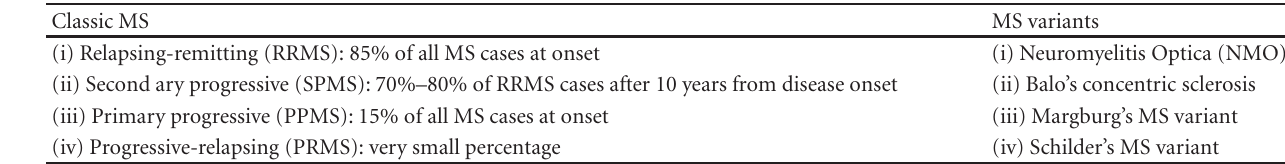
Table 1: Classic MS and its